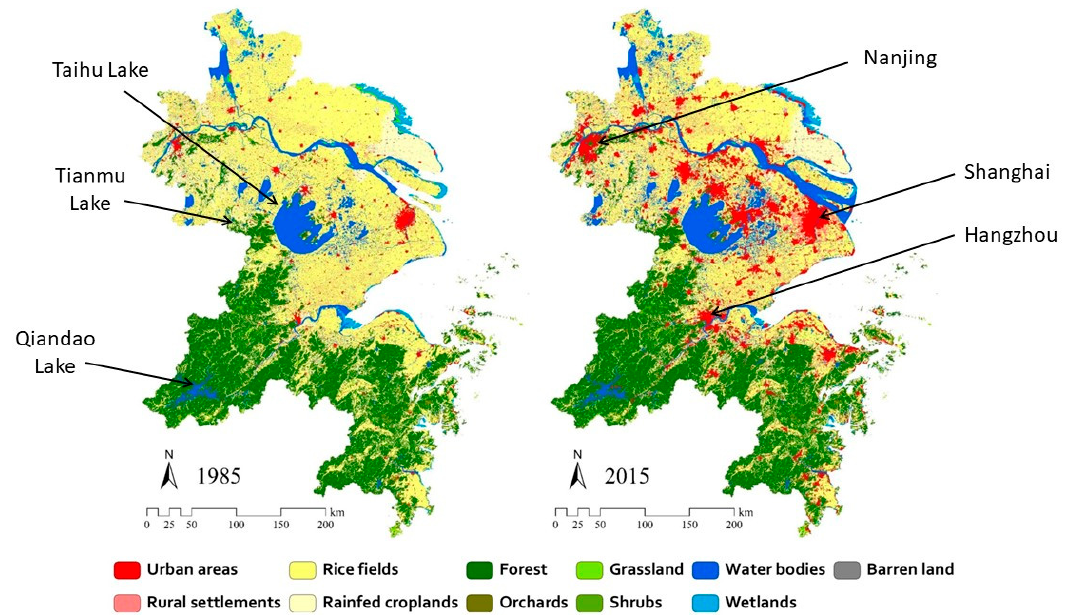
Figure 1. The Yangtze River Delta of Eastern China showing land cover / land use as of 1985 and 2015. Taihu Lake, and the locations of Tianmu Lake and Qiandao Lake, are indicated on the left. Major cities are identified on the right.